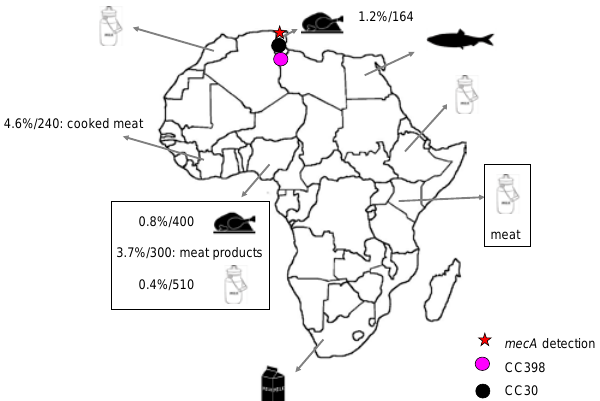
Figure 3. Food products, clonal lineages and prevalence of MRSA identified in the Africa continent. Prevalence (%) is calculated considering the total number of samples of each animal species included in the different studies and is indicated when this estimation is possible with the data shown in each publication. Moreover, in those cases, the number of samples studied is also indicated (%/number of samples). The clonal complexes were determined by e-BURST.